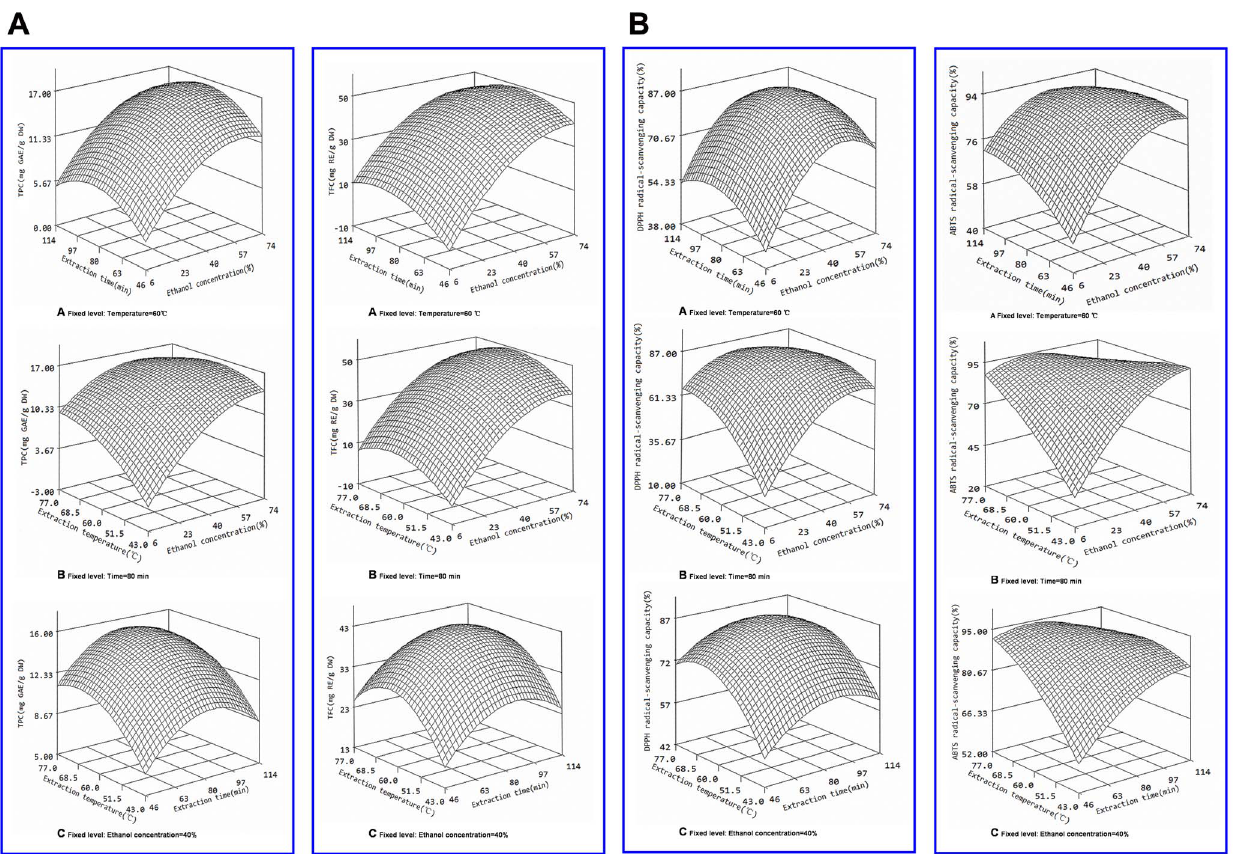
Figure 2. Response surface plots of TPCs of C.cyrtophyllum leaf extracts as affected by ethanol concentration, temperature, and time in UAE. (A) Ethanol concentration and time (temperature 60 u C); (B) ethanol concentration and temperature (time 80 min); (C) temperature and time (40% ethanol).